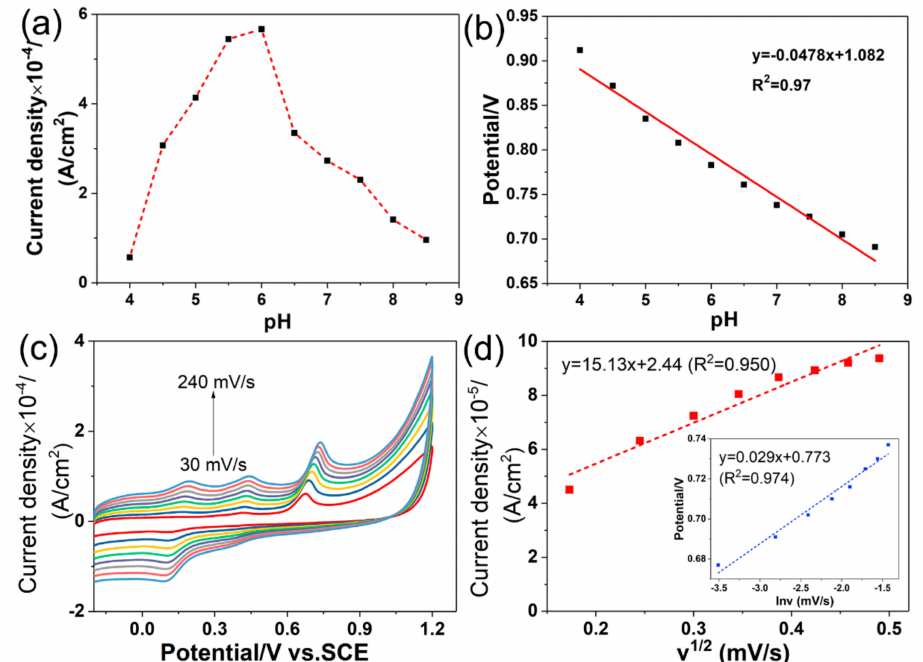
Figure 4. E ff ects of the pH on the oxidation peak currents of tryptophan (1.0 × 10 − 5 mol / L) at